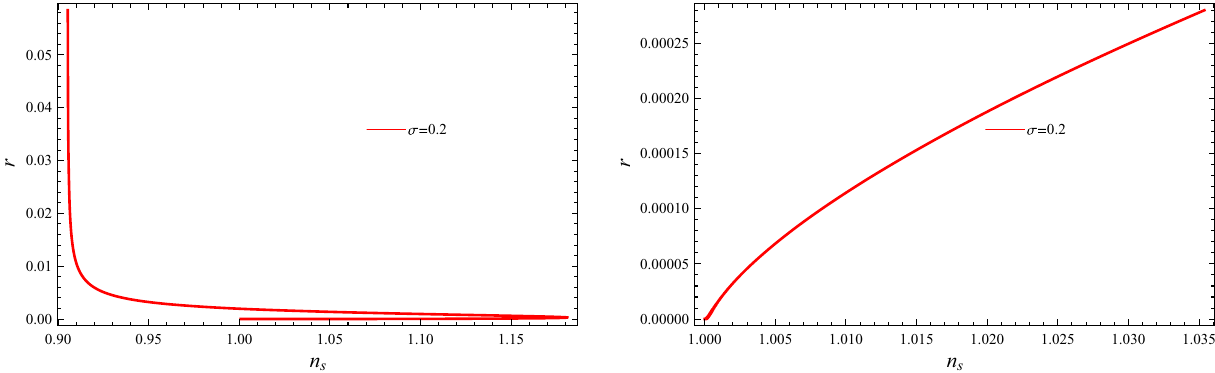
Fig. 7 Plot of r versus n s for MCG model in weak (left panel) and strong (right panel) dissipative regimes for positive potential with n = 1